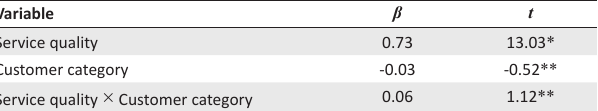
TABLE 5: Moderated regression